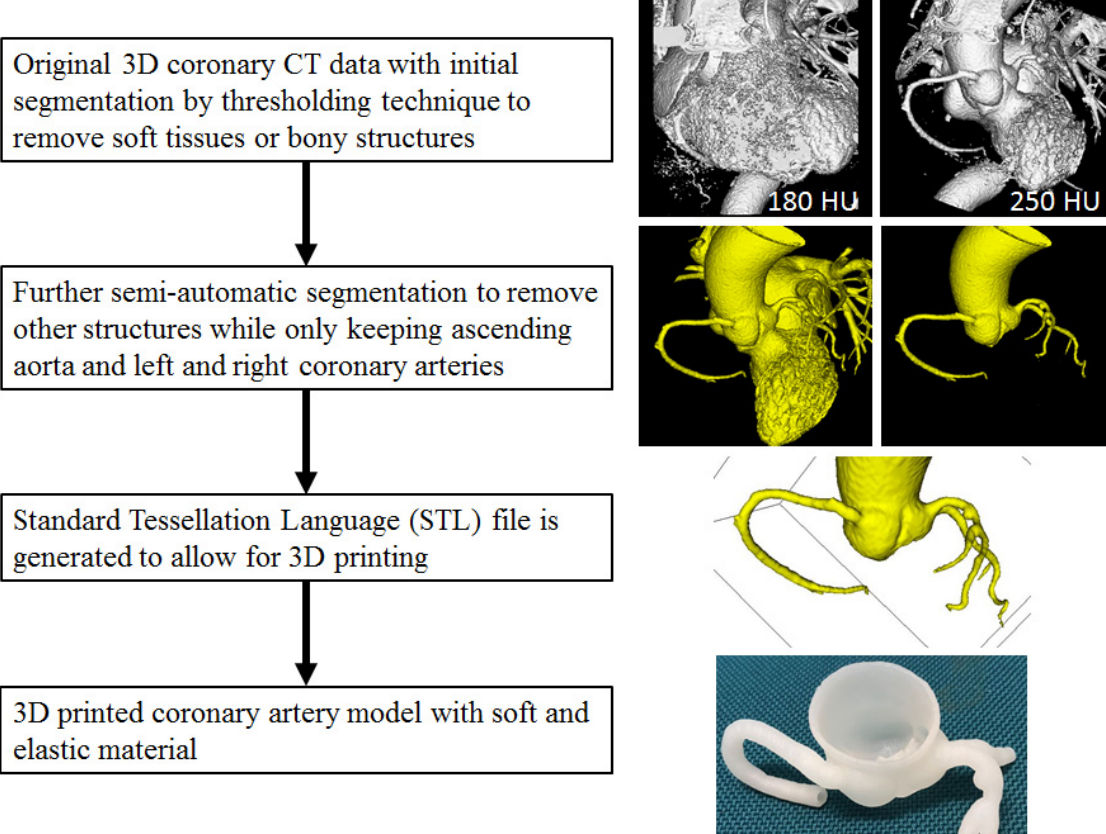
Figure 2. Steps to generate 3D printed models through image post-processing and segmentation of coronary CT images to extract the ascending aorta and coronary tree from the original volume data to STL file for printing 3D model. Reprinted with permission under open access from Sun [21].